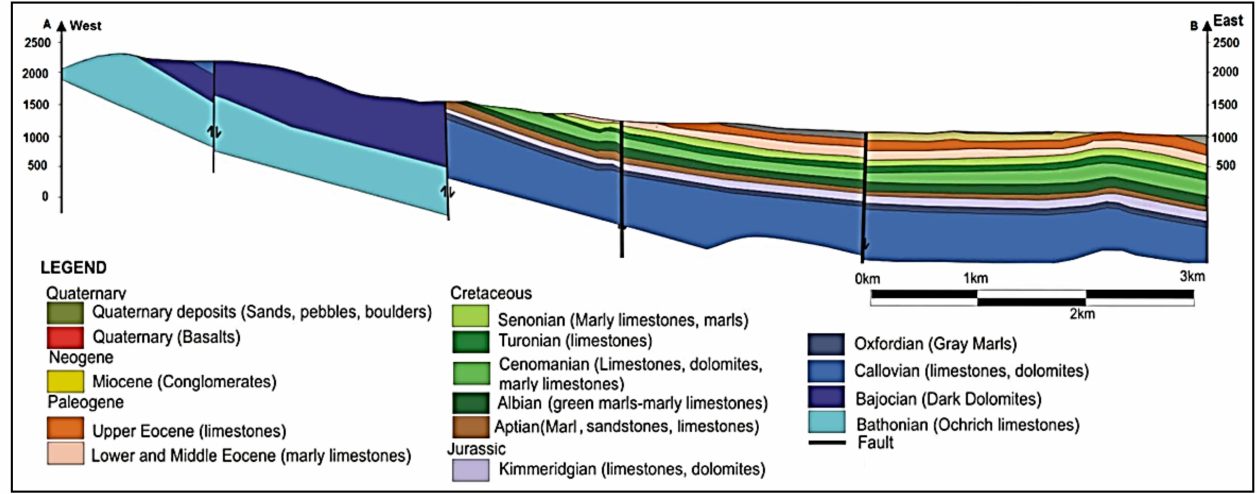
Figure 4. Geological cross section showing subsurface lithology in the study area as well as the major structure within this area, updated after